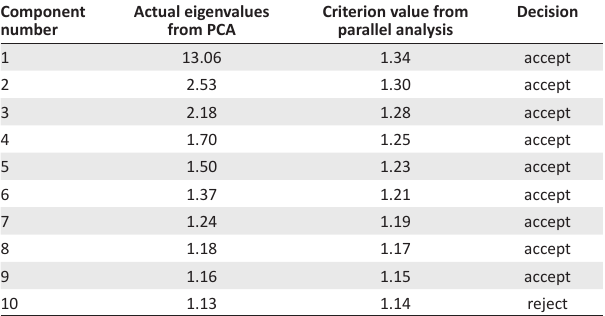
TABLE 2: Results of the Monte Carlo parallel analysis.